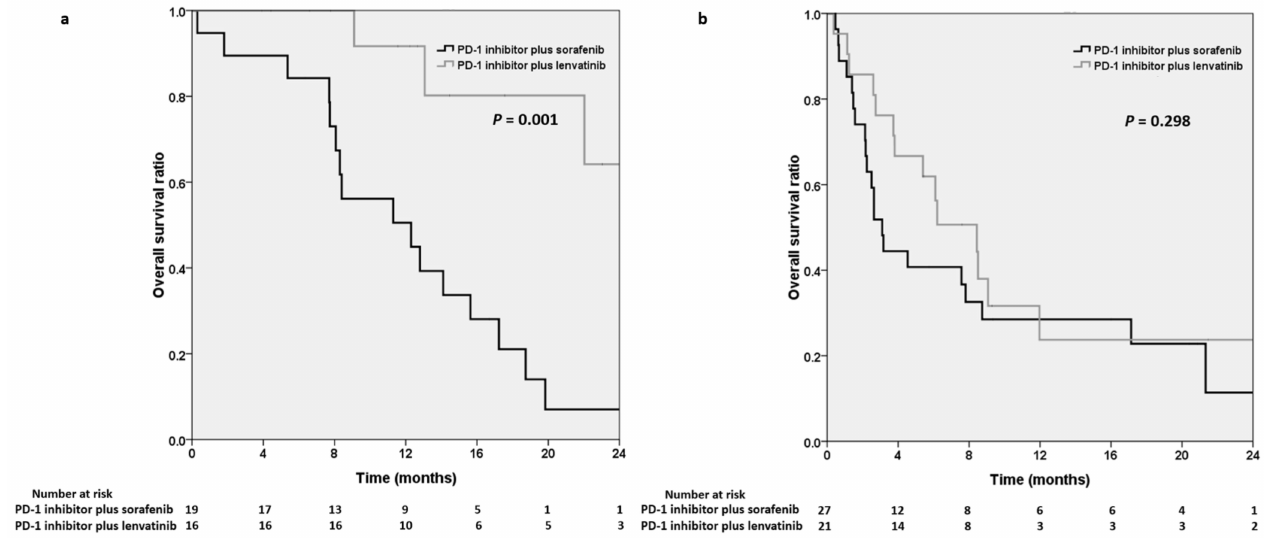
Figure 3. Kaplan–Meier analysis illustrating overall survival in the PD-1 inhibitors plus sorafenib group and the PD-1 inhibitors plus lenvatinib group in patients with albumin–bilirubin (ALBI) grade 1 ( a ) and ALBI grade 2 or 3 ( b ), respectively. PD-1, programmed cell death